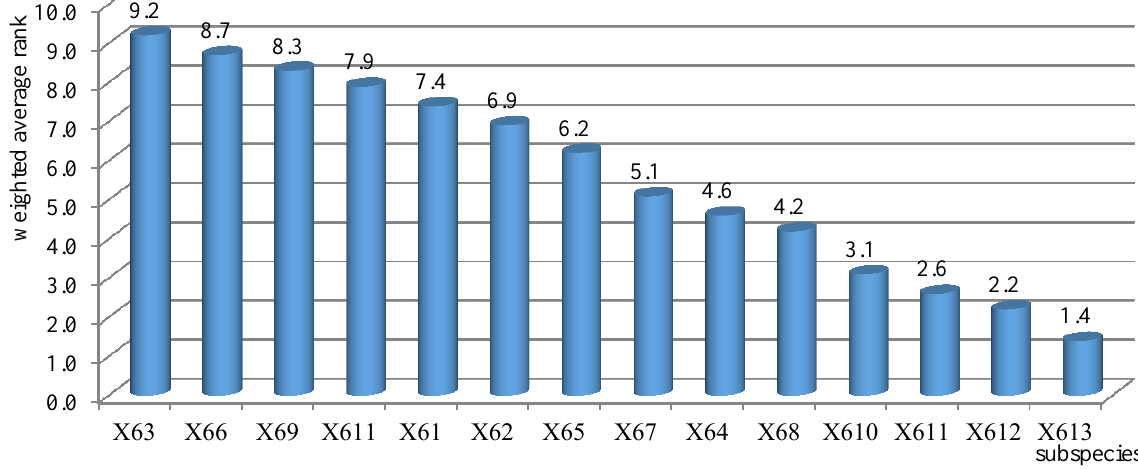
Fig. 4. Histogram risk sharing procurement in the field of FEA